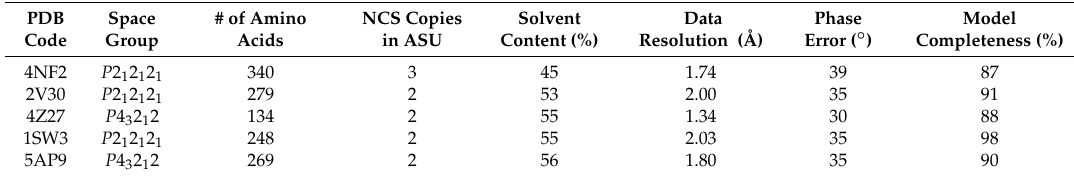
Table 1. Results of the trial calculations.